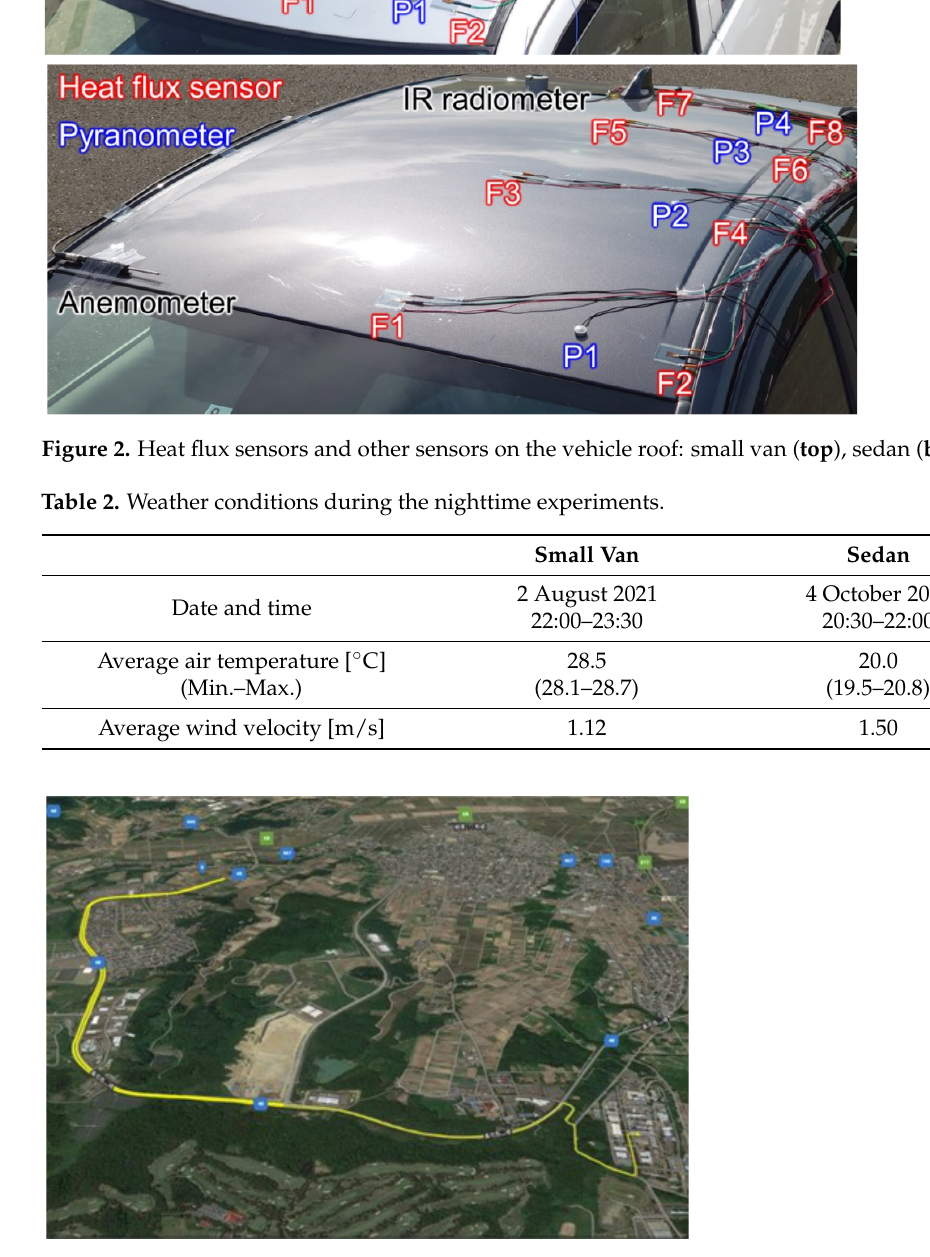
Figure 3. Driving route (Nagaoka city, Niigata, Japan). Table 1. Specifications of the sensors used.